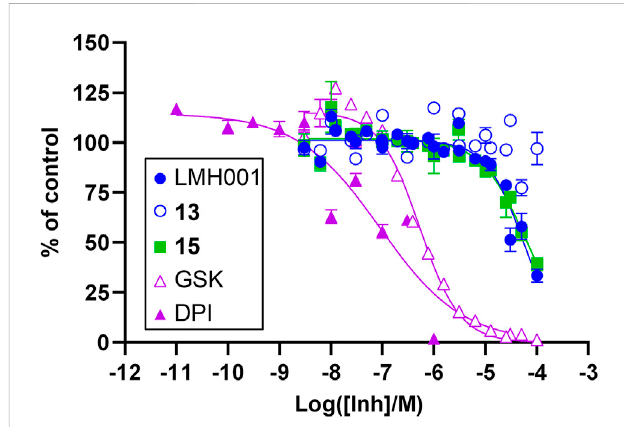
FIGURE 4 Inhibitory effects of LMH001 (IC 50 = 54 μ M), 13 , 15 (IC 50 = 63 μ M) andthecontrol compounds GSK2795039